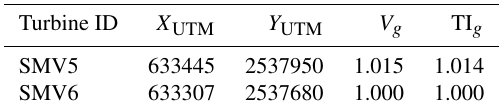
Table 5. P4: non-homogeneous factors for the single-wake